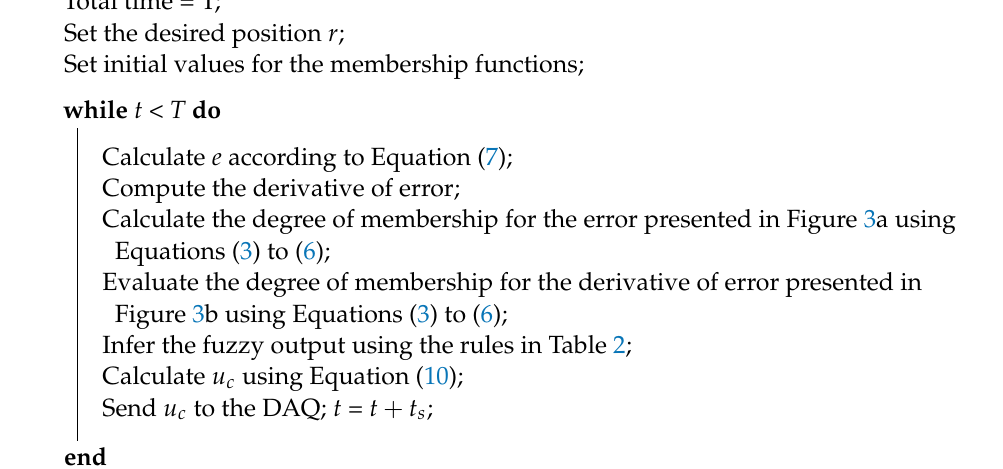
Algorithm 1: Pseudocode of the fuzzy